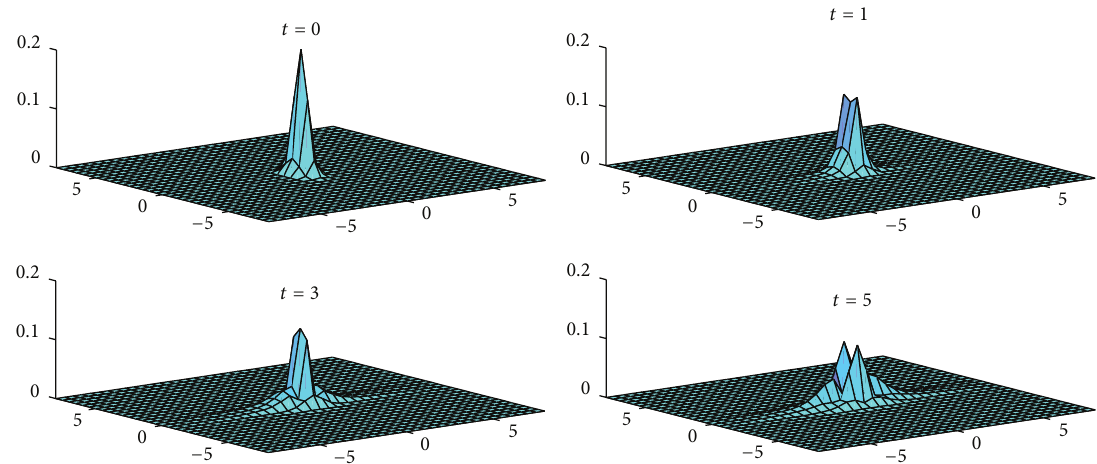
Figure 5: The wave function evolution according to time. Surface plots for |𝜑 1 (𝑥,0, 𝑧, 𝑡)| 2 at different times.